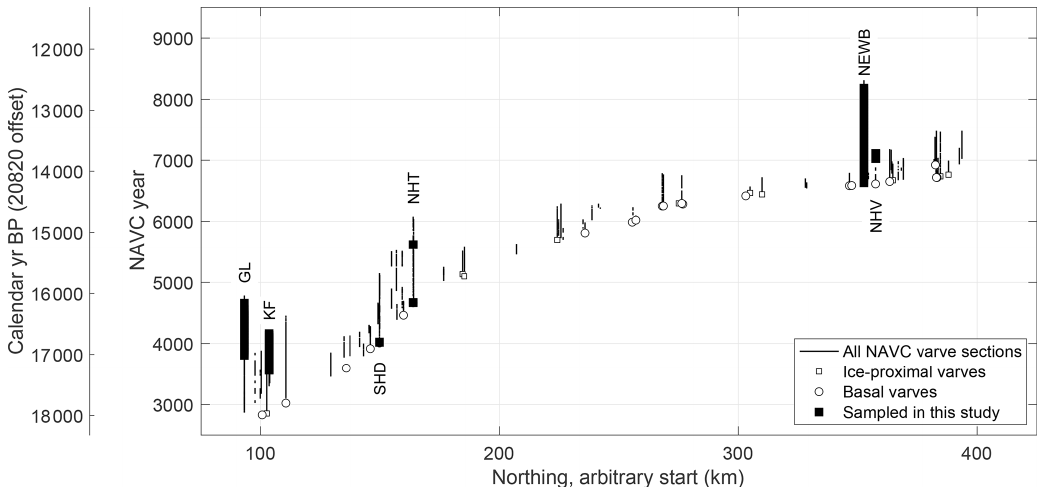
Figure 2. Time–distance diagram for NAVC varve sections, highlighting sections sampled in this paper. Thin lines show the age range and location of varve sections in central New England that are correlated with the NAVC. Circles and squares highlight basal or ice-proximal varves, respectively, that indicate the location of the ice margin in a given varve year. Thick lines at labeled sections indicate portions of these sections analyzed in this study. As in Fig. 1, the 930PN section in New York is not shown here. The calendar year BP timescale at left uses the value of 20820 years for the NAVC year–calyrBP offset from Thompson et al. (2017); see discussion in Sect.